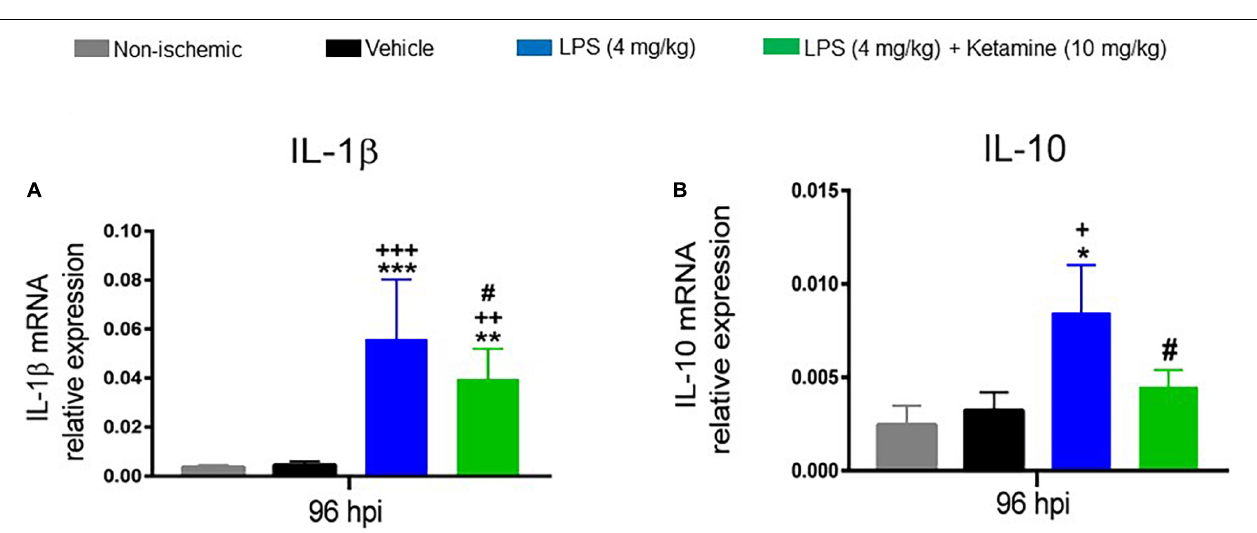
FIGURE 5 | Effects of LPS and ketamine on post-ischemic GFAP , CD86, and CD206 expression. Expression of (A) GFAP , (B) CD86 , and (C) CD206 mRNAs in the ischemic brain tissue of mice exposed to sham surgery or transient MCAO, which were treated with vehicle or LPS (4 mg/kg) at 24 hpi followed by vehicle or ketamine (10 mg/kg) 30 min later. Gene expression was assessed at 96 hpi by RT-PCR. Note that LPS-induced sepsis significantly increased GFAP , CD86 , and CD206 mRNA levels. Ketamine did not influence GFAP , CD86 , and CD206 mRNAs. Data are mean ± SEM values ( n = 3 animals/group). * P < 0.05; ** P < 0.01 compared with non-ischemic sham surgery; + P < 0.05; ++ P < 0.01; +++ P < 0.001 compared with ischemic vehicle.